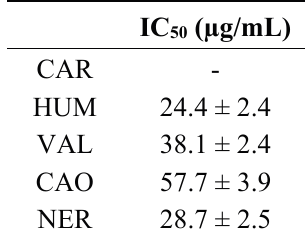
Table 1. IC 50 values of individual sesquiterpenes in CaCo-2 cells after 72 h incubation.